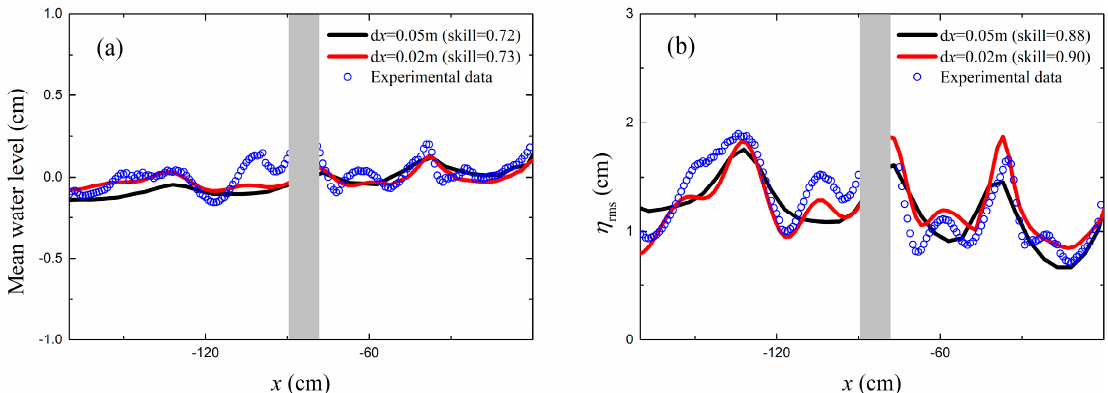
Figure 4. Comparisons of predicted and measured spatial distribution of ( a ) mean water level and ( b ) η rms for the wave case with H i = 4.7 cm, T i = 1.2 s, h s = 3 cm.